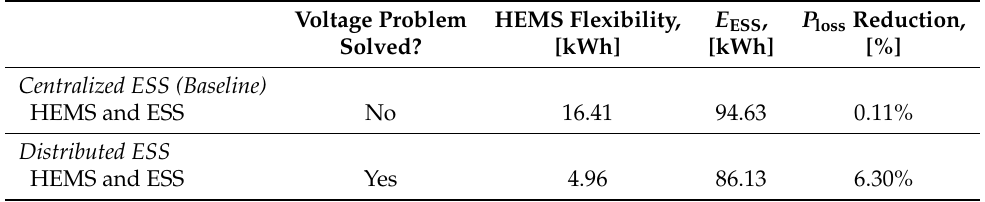
Table 7. Baseline and distributed ESS comparison, considering the control of “HEMS and ESS”.